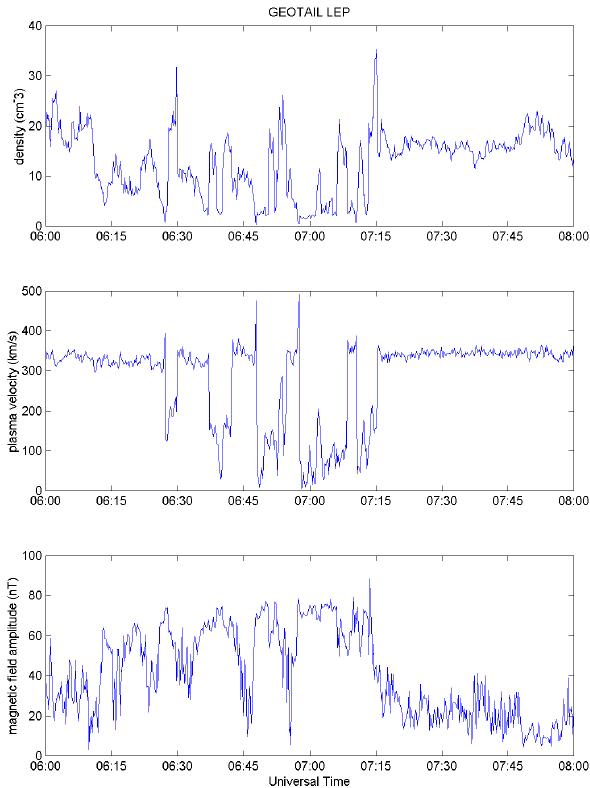
Fig. 3. Geotail data showing multiple magnetopause cross- ings/incursions. From top to bottom: ion density, ion velocity, and magnetic field amplitude.